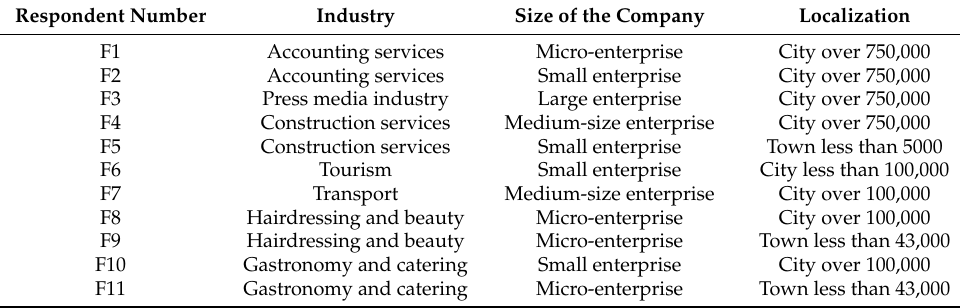
Table 1. Business taking part in the qualitative